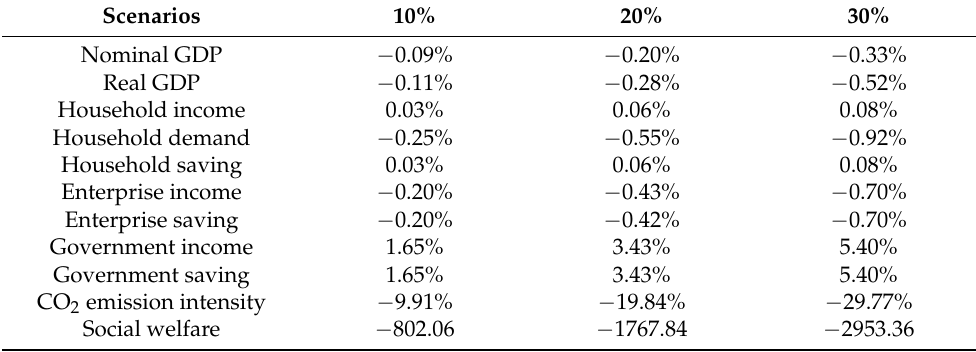
Table 3. Statistics of macroeconomic variables.